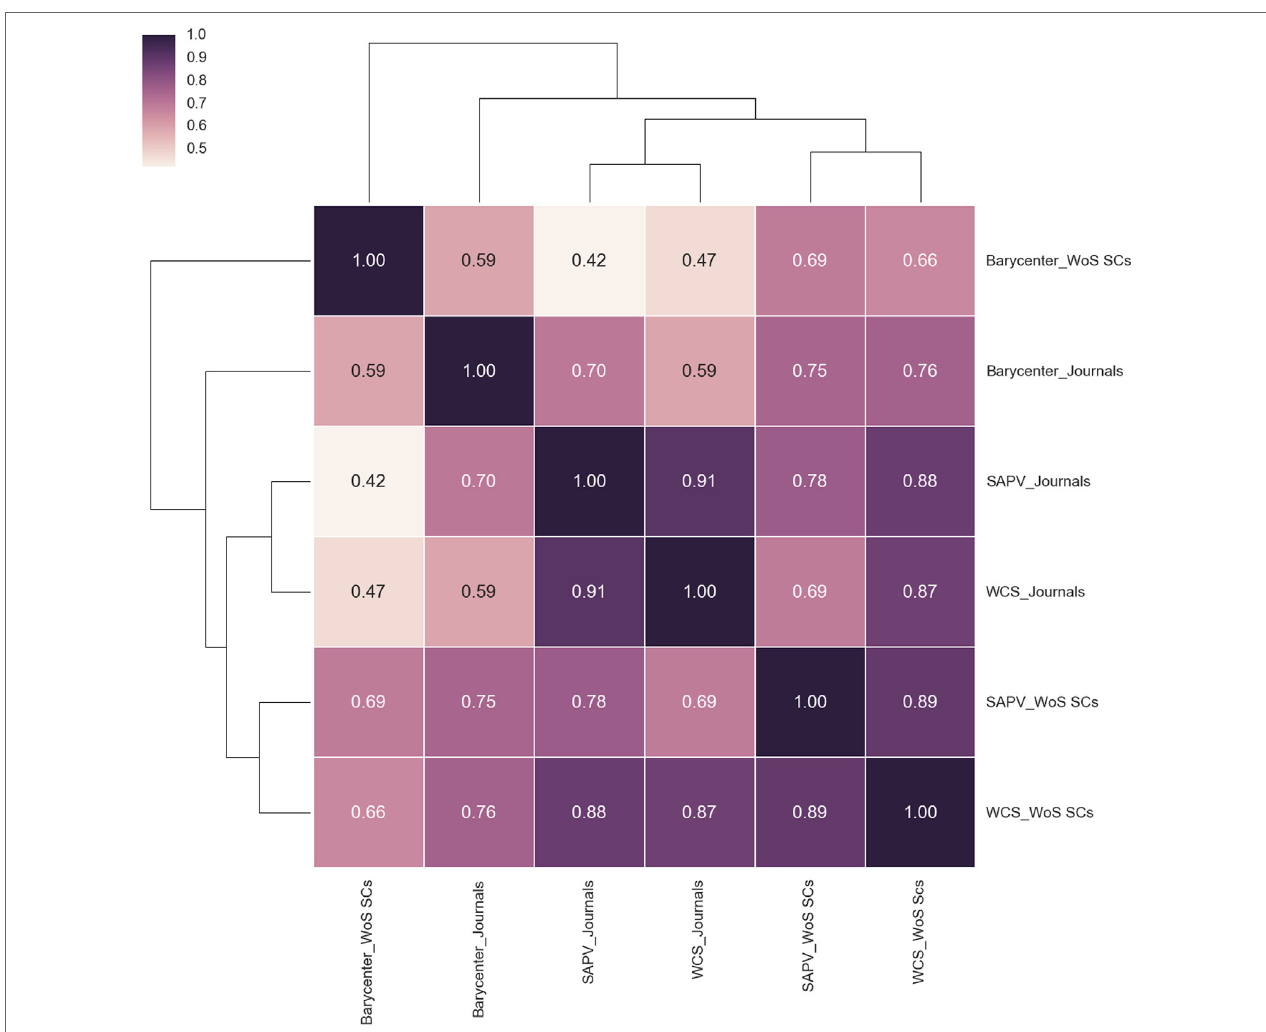
FigUre 2 | Heat map with hierarchical clustering based on correlation coefficient between six approaches in the Biology